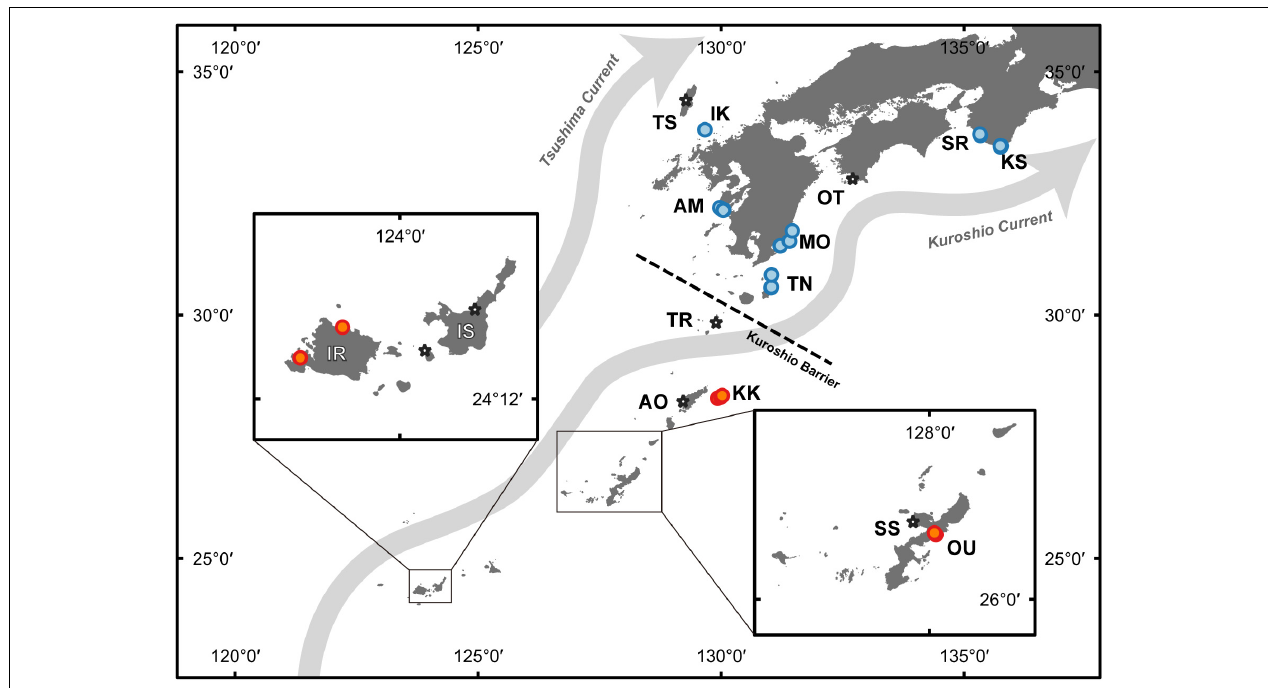
FIGURE 1 | Map of sampling locations. Stars indicate sampling sites collected for development of microsatellite markers, and circles indicate samples used for genotyping analysis. Blue indicates temperate populations, and orange indicates subtropical populations. The Kuroshio Barrier (Nakabayashi et al., 2019) is shown as a dashed line. The corresponding site names for the abbreviations in the map can be found in Table 1